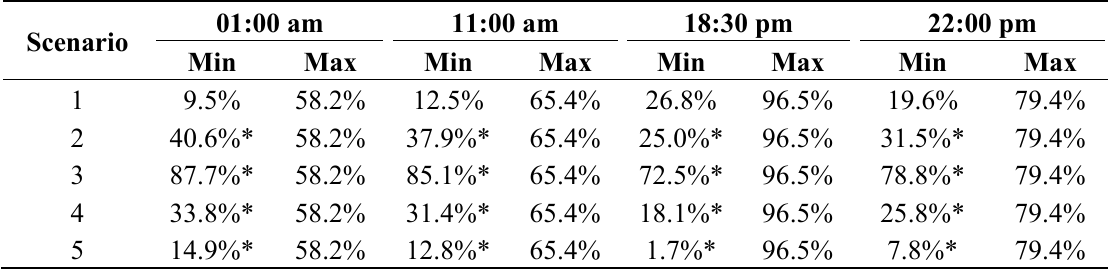
Table 3. 11 kV/400 V transformer loadings at different times of the